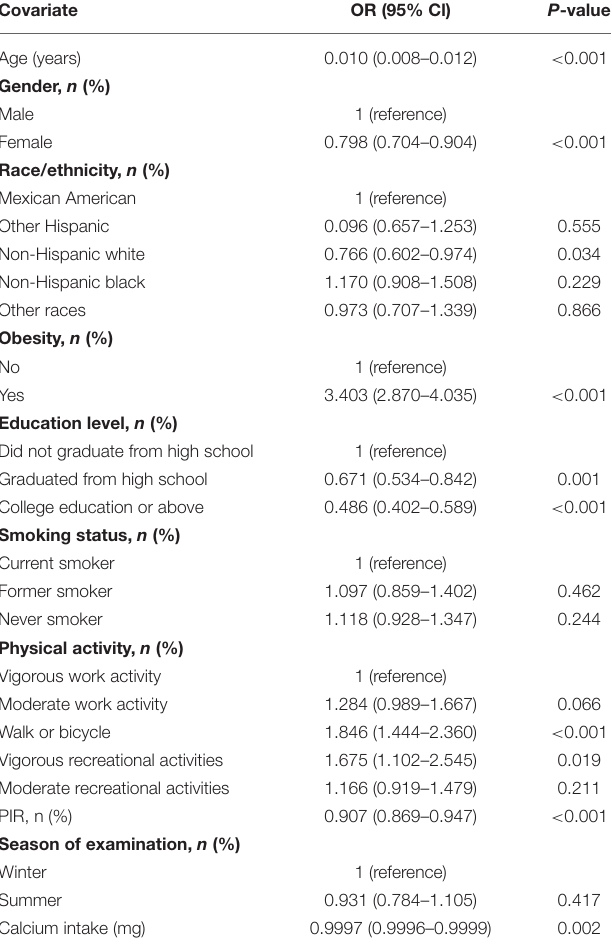
TABLE 2 | Association of covariates and T2D risk.